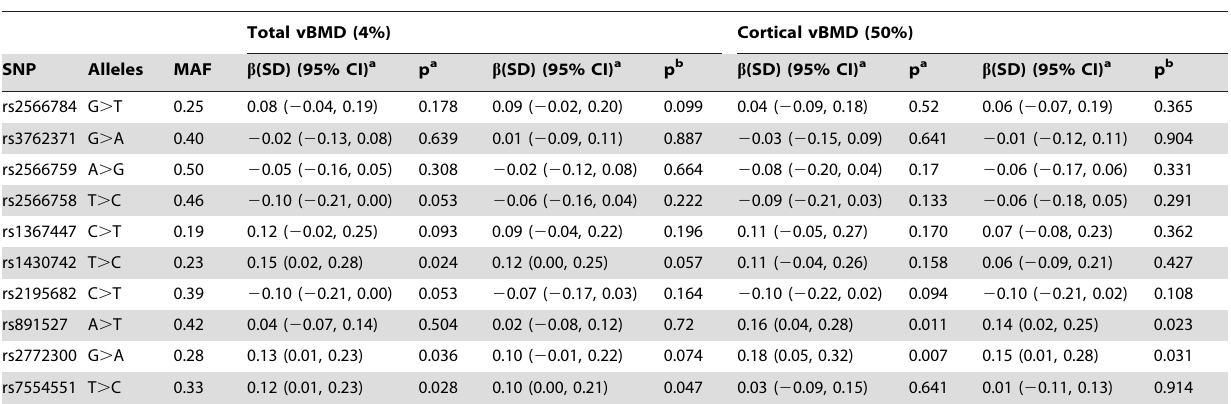
Table 3. Genetic association between GPR177 SNPs and BMD v .